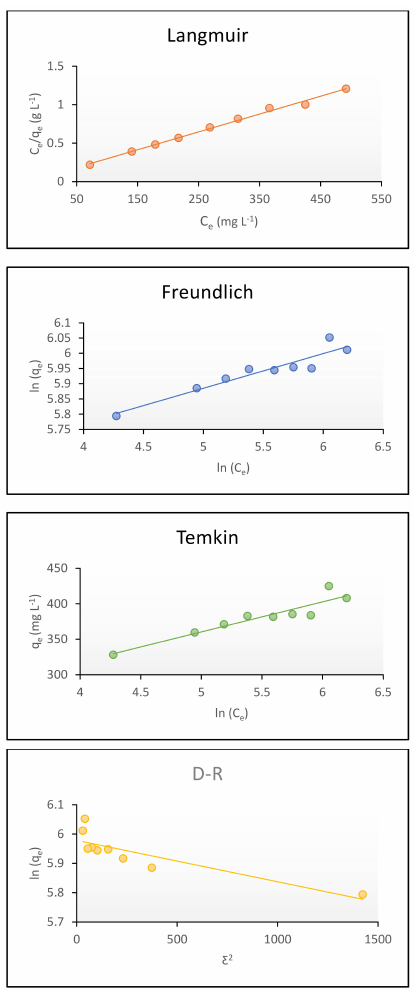
Figure 14. Adsorption isotherms for CR dye onto UCs at 55 ◦ C and pH